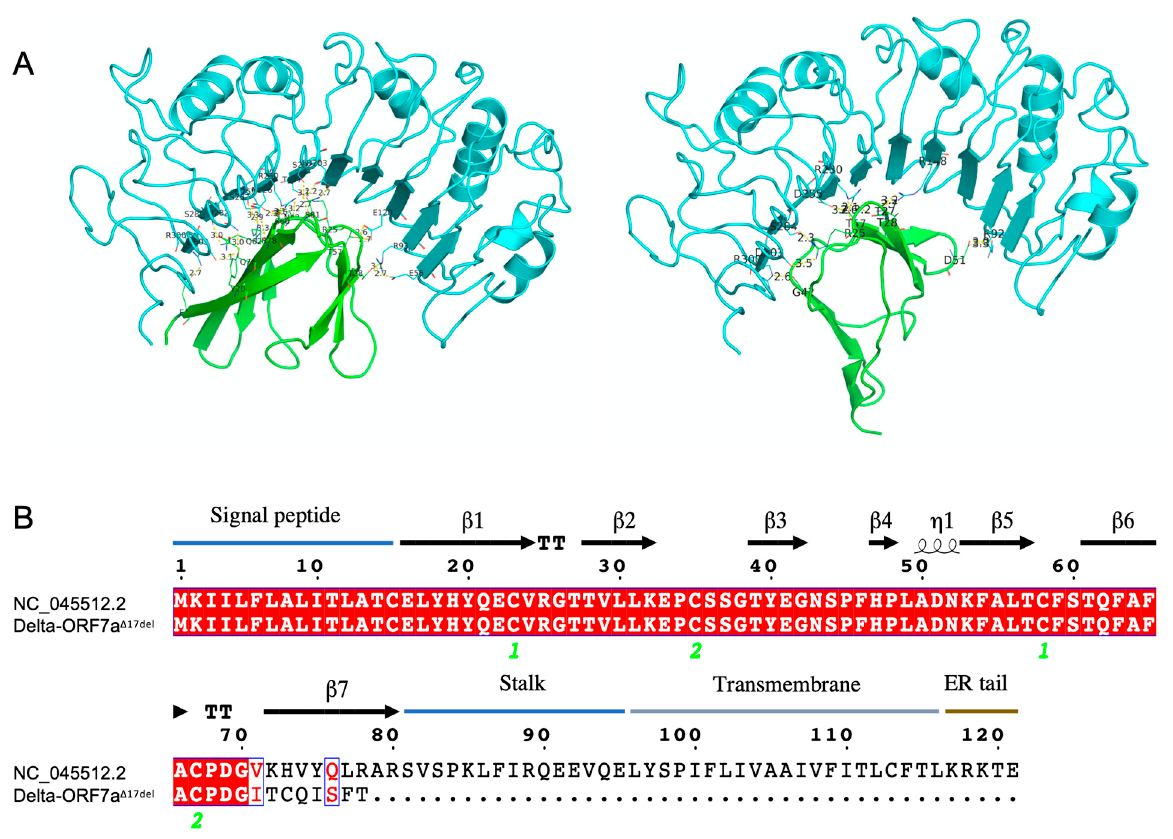
Figure 3. The estimated structure of the ORF7a protein in SARS-CoV-2 and the consequences of a deletion of 17 nucleotides within ORF7a spanning genomic positions 27607–27623 (ORF7a Δ 17del ) on this structure. ( A ) The ORF7a protein from the Wuhan-Hu-1 reference genome (PDB ID: 7CI3, green) docking with human CD14 (PDB ID: 4GLP, turquoise), as modelled using HDOCK [18]. ( B ) The inferred peptide sequence of the ORF7a protein in SARS-CoV-2 which demonstrated the peptide and structural changes within the Delta-ORF7a Δ 17del variant. The ORF7a Δ 17del deletion occurred after the 6th beta sheet in Delta-ORF7a Δ 17del , which led to 7 novel amino acids, followed by a stop codon, and caused the loss of the 7th beta sheet, the C-terminal transmembrane domain, and the cytoplasmic di-lysine motif (KRKTE) that determines ER localisation. The alignment was created using Esprit 3.0 [16].